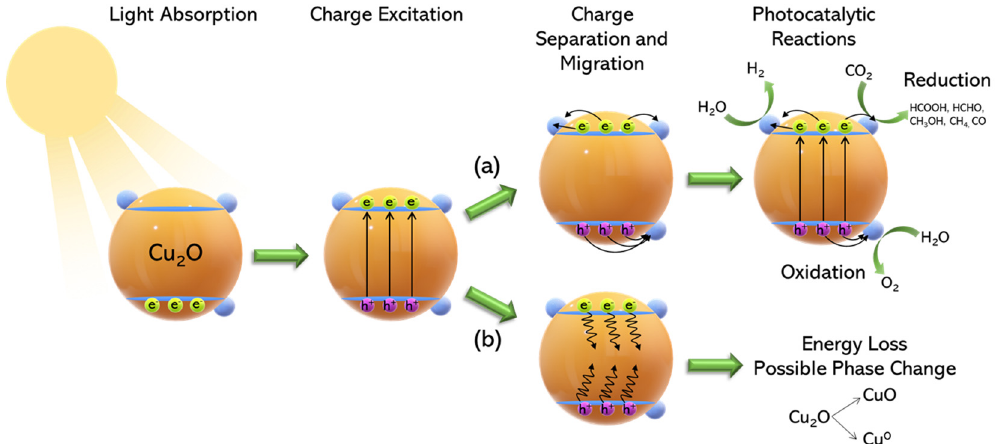
Figure 1. Schematic description of the photoexcitation-related reaction paths in Cu 2 O semiconductors in path ( a ) electron-hole pairs are utilized for “Artificial-Photosynthesis”. In path ( b ), detrimental phase-transformation can occur due to photocorrosion.